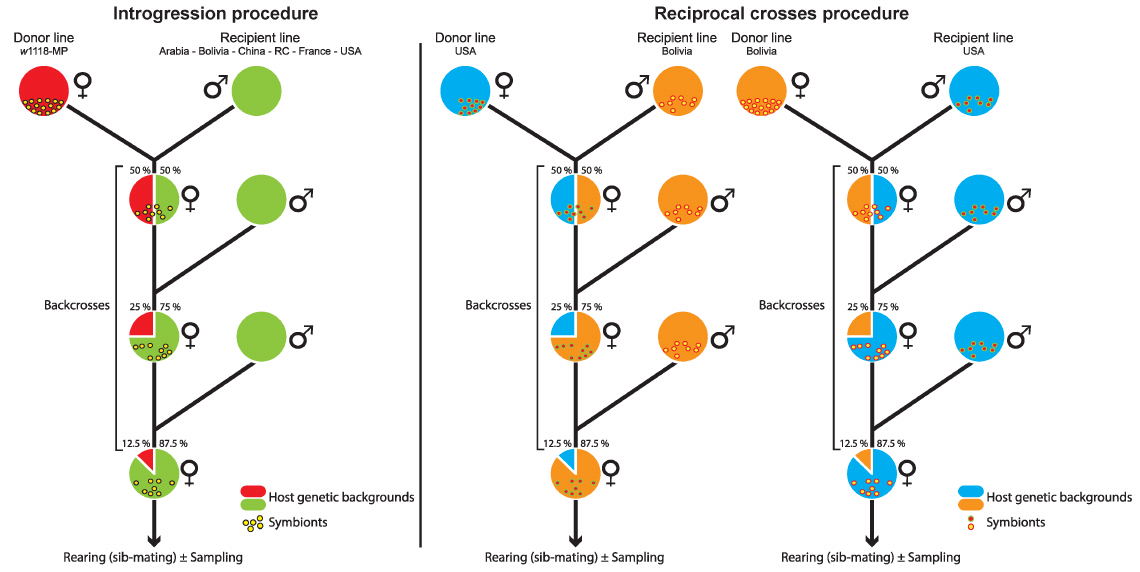
Figure 1: Introgression and reciprocal crosses procedures. Transmission of symbionts from females of the donor line to a recipient line. Serial backcrosses were performed to restore the recipient host genetic background by mating daughters from the previous cross with males from the recipient line. This method was applied to infect the 6 natural Drosophila melanogaster populations by w Melpop (experiment #1, left panel), to perform new introgressions from Bolivia or USA on 3 replicates (experiment #2, left panel) and to conduct reciprocal crosses (experiment #3, right